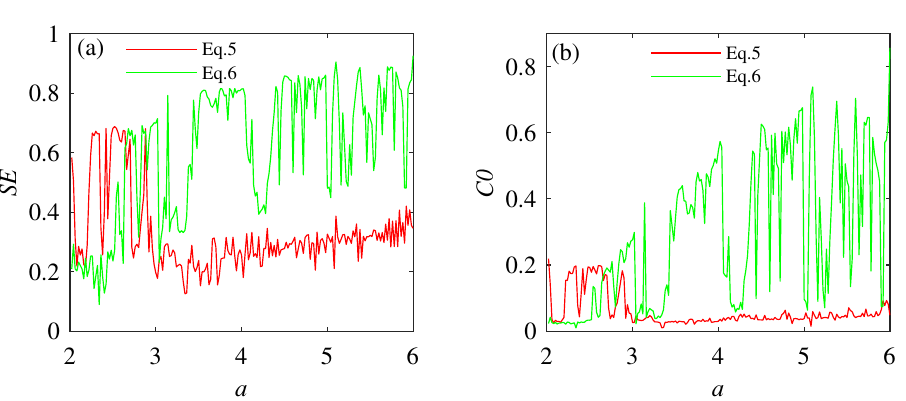
Figure 4. Bifurcation diagrams of systems (6) and (7) under the condition of unknown parameter a initial value selection (0.1,0.1,0.1). ( a ) Bifurcation diagram of system (6). ( b ) Bifurcation diagram of system (7).